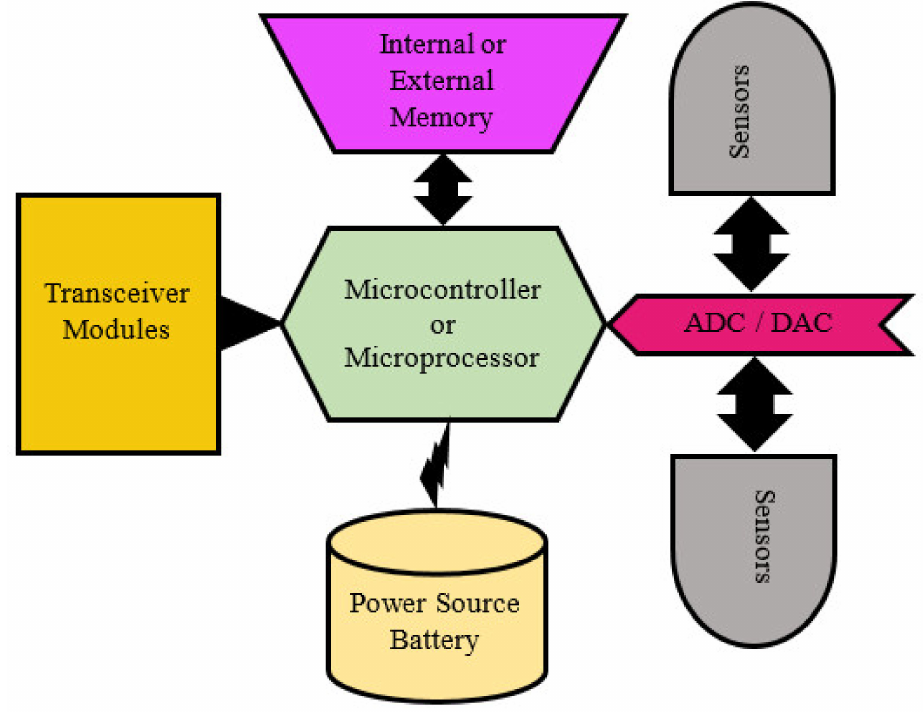
Figure 1. Internal components of sensor